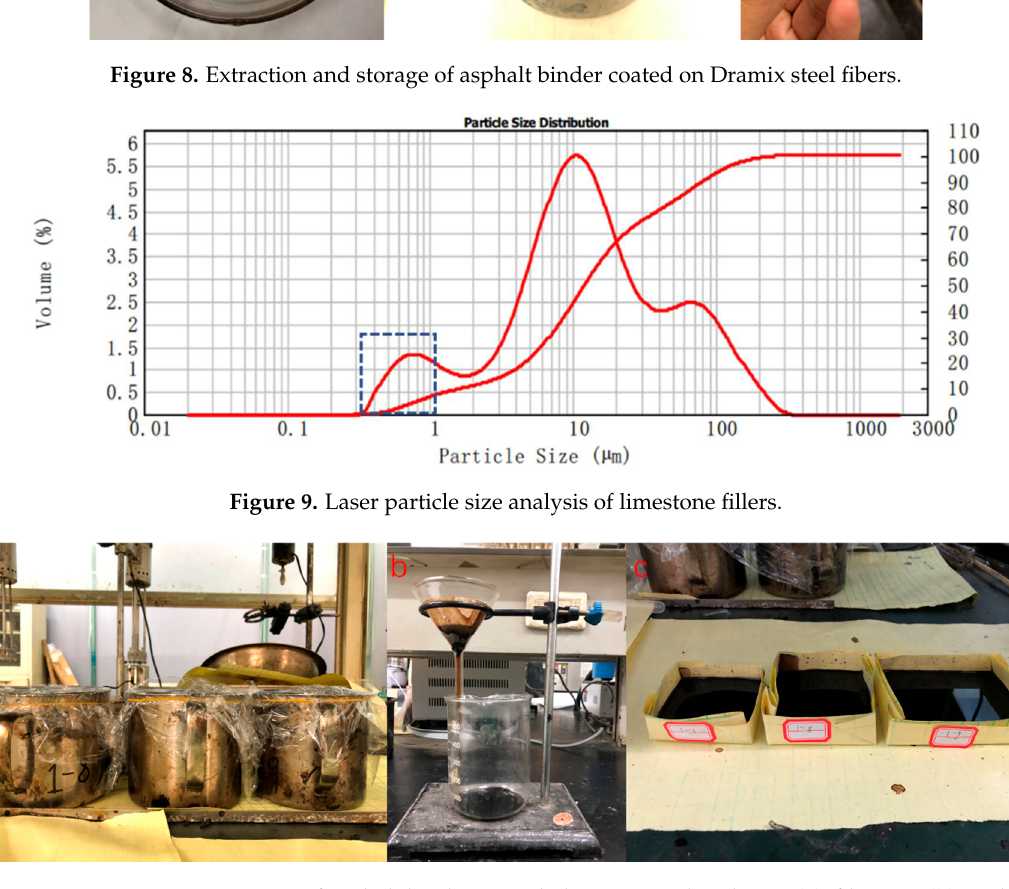
Figure 10. Extraction process of asphalt binder in asphalt concrete: dissolution ( a ), filtration ( b ), and volatilization ( c ).